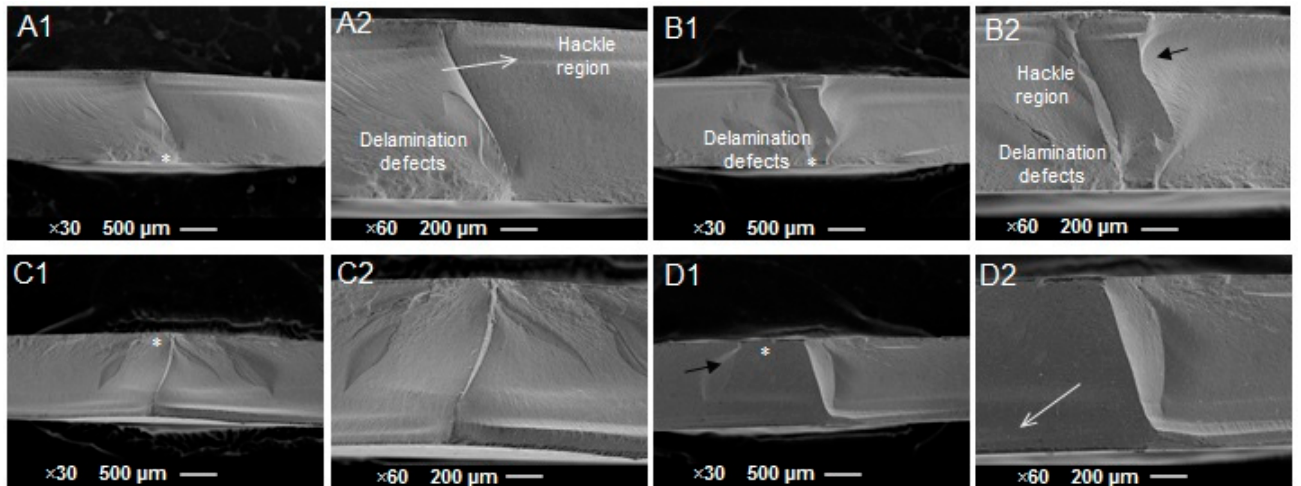
Figure 7. SEM images of fractured surface of representative CU specimen following BFS test: ( A1 ) control specimen showing the origin (asterisk) of the fracture. Multiple crack planes and voids are also shown; ( A2 ) higher magnification showing compression curl, delamination defects, and hackle region (solid white arrow); ( B1 , B2 ) MP specimen showing similar fracture features displayed in the control group in addition to distinctive multiple fracture planes and arrest lines (solid black arrow); ( C1 ) OG specimen shows the crack origin; ( C2 ) higher magnification shows multiple fracture plane, voids, and hackle regions; ( D1 ) MP+PP specimen showing origin of the crack as well crack arrest lines (solid black arrow); ( D2 ) multiple crack planes, compression curl, and hackle region are shown.